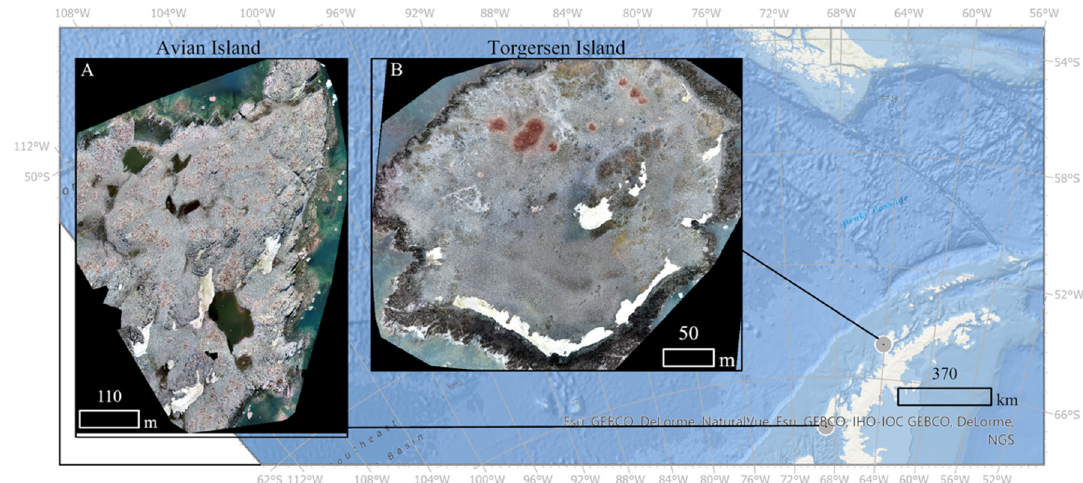
Figure1. Mapindicatinglocationsofstudysites. AvianIsland( A )islocatedatapproximately67 ◦ 46 (cid:48) 21”S, Figure 1. Map indicating locations of study sites. Avian Island ( A ) is located at approximately 68 ◦ 53 (cid:48) 19”W. Approximately 1 / 3 of Avian Island was surveyed on 15 January 2017. Torgersen Island 67°46 ′ 21 ″ S, 68°53 ′ 19 ″ W. Approximately 1/3 of Avian Island was surveyed on 15 January 2017. ( B ) is located north of Avian Island at approximately 64 ◦ 46 (cid:48) 17”S, 64 ◦ 04 (cid:48) 31”W. All of Torgersen Island Torgersen Island ( B ) is located north of Avian Island at approximately 64°46 ′ 17 ″ S, 64°04 ′ 31 ″ W. All was surveyed on 6 February of Torgersen Island was surveyed on 6 February 2017.